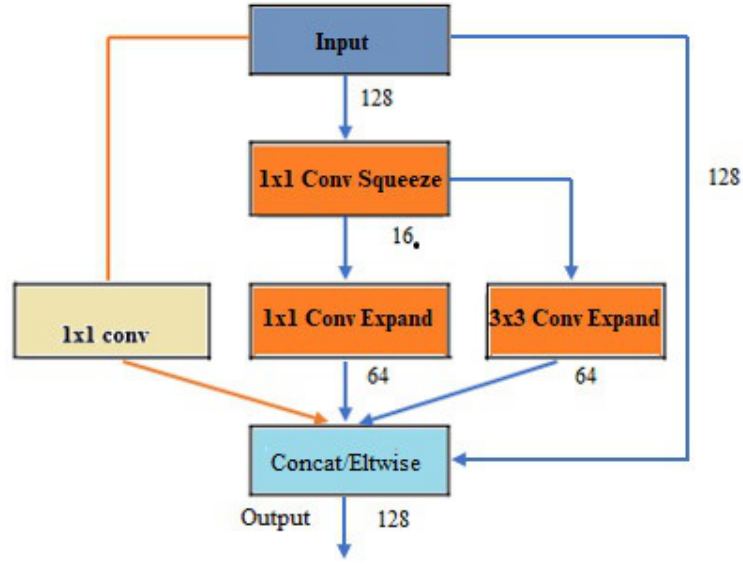
Figure 2. The schema for concatenation.